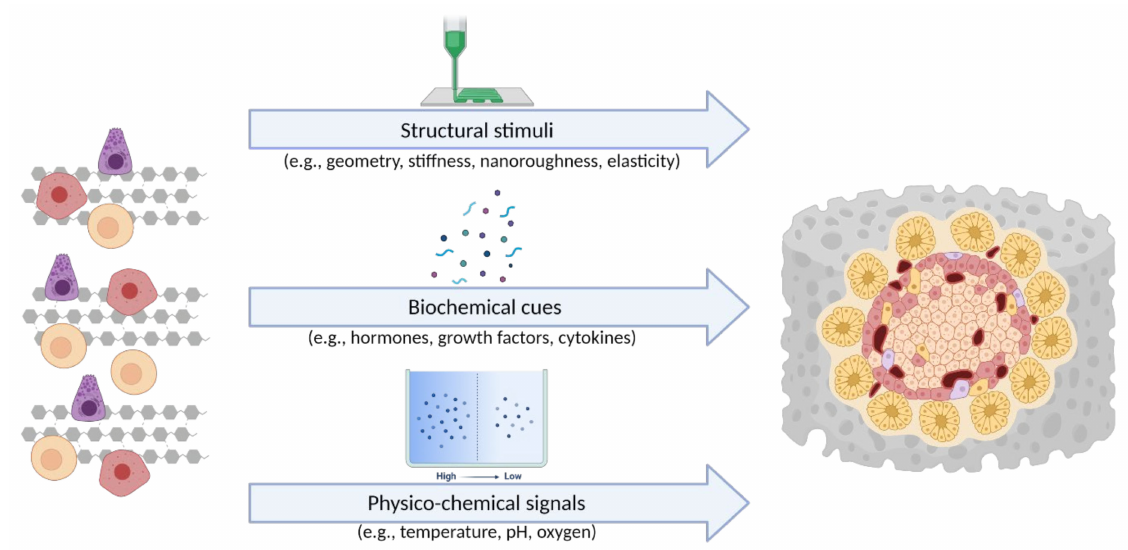
Figure 3. The three groups of cues, which act on cells in a 3D in vitro model [105] (created with BioRender.com; accessed on 6 July